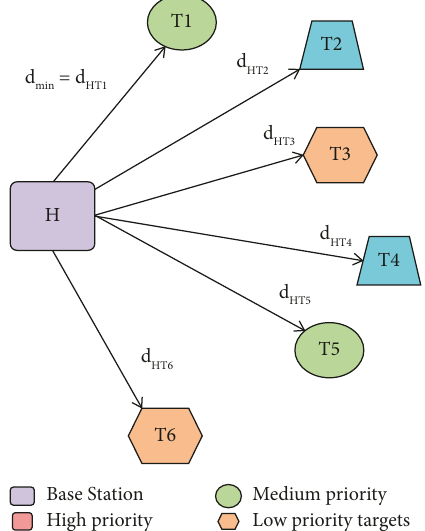
Figure 5: Proposed layout showing distances between the targets and the base station.